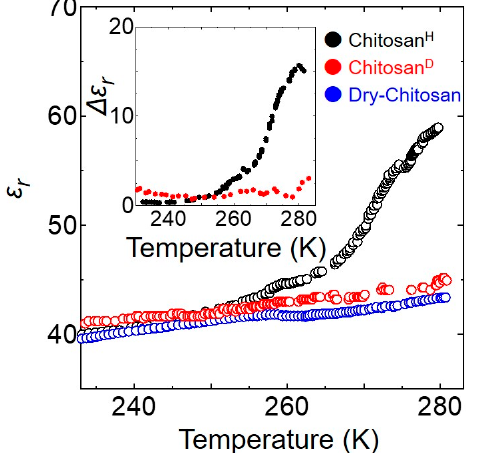
Figure 3. Temperature dependence of the ε r values of the Chitosan H , Chitosan D , and Dry-Chitosan samples between 230 and 280 K. The inset shows the temperature dependence of Δε r .